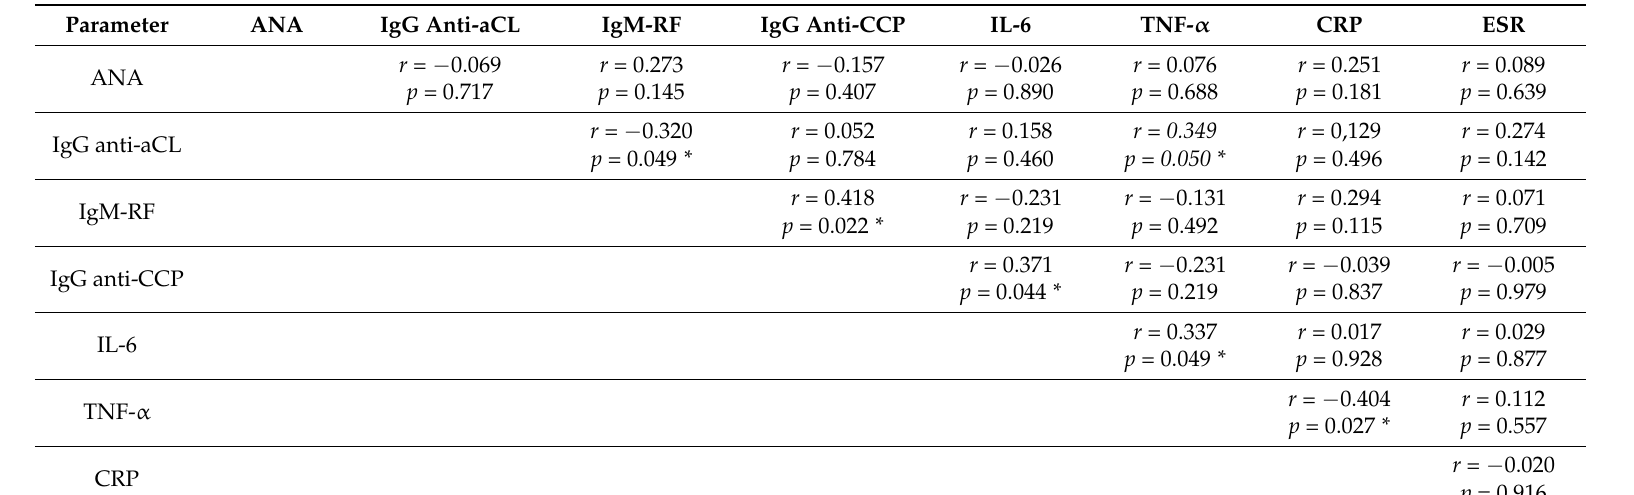
Table 3. Correlations between IL-6, THF- α and early rheumatoid arthritis (eRA)